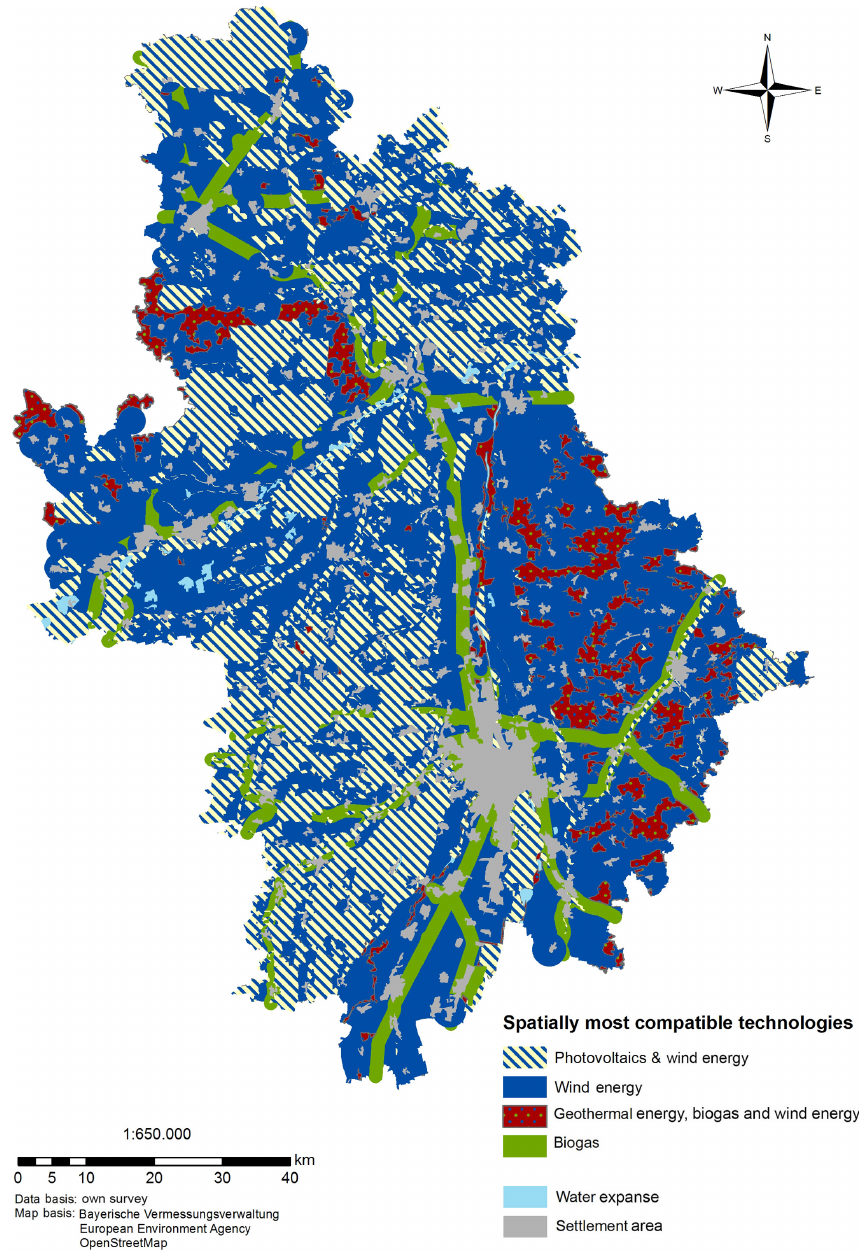
Figure 4. Spatially compatible assignment of technologies – scenario technological progress.